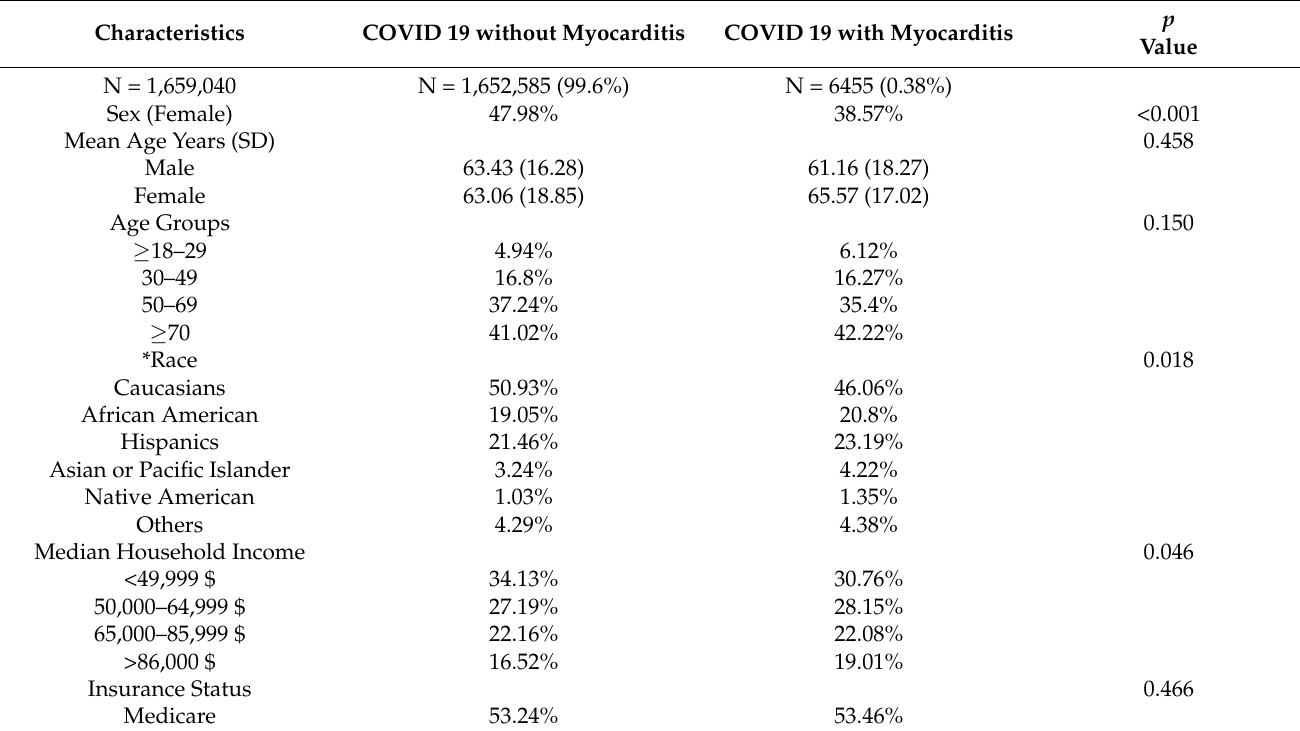
Table 1. COVID-19 and Myocarditis Unmatched Patient-level